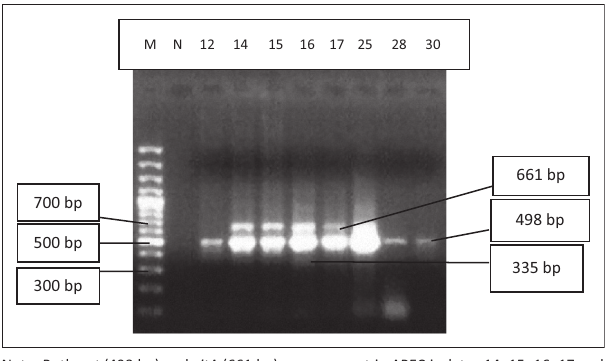
FIGURE 4: Multiplex 4. Lane M indicates the lane containing the marker, GeneRuler 100 bp Plus DNA Ladder (Thermo Scientific, Waltham, Massachusetts, USA) whilst lane N indicates the negative